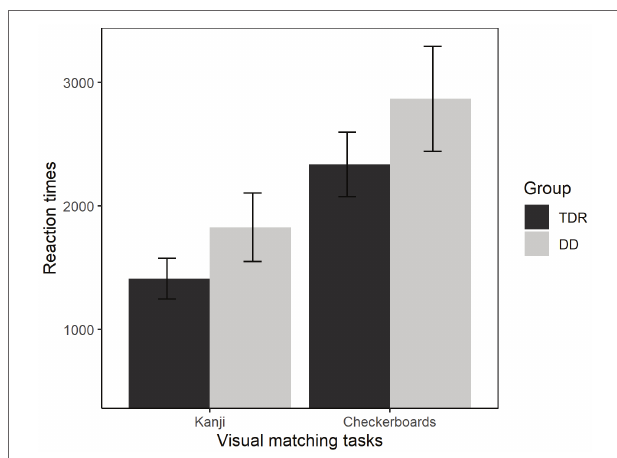
FIGURE 7 | Reaction times in visual tasks. Error bars represent standard errors. TDR, typically developing readers, DD, developmental